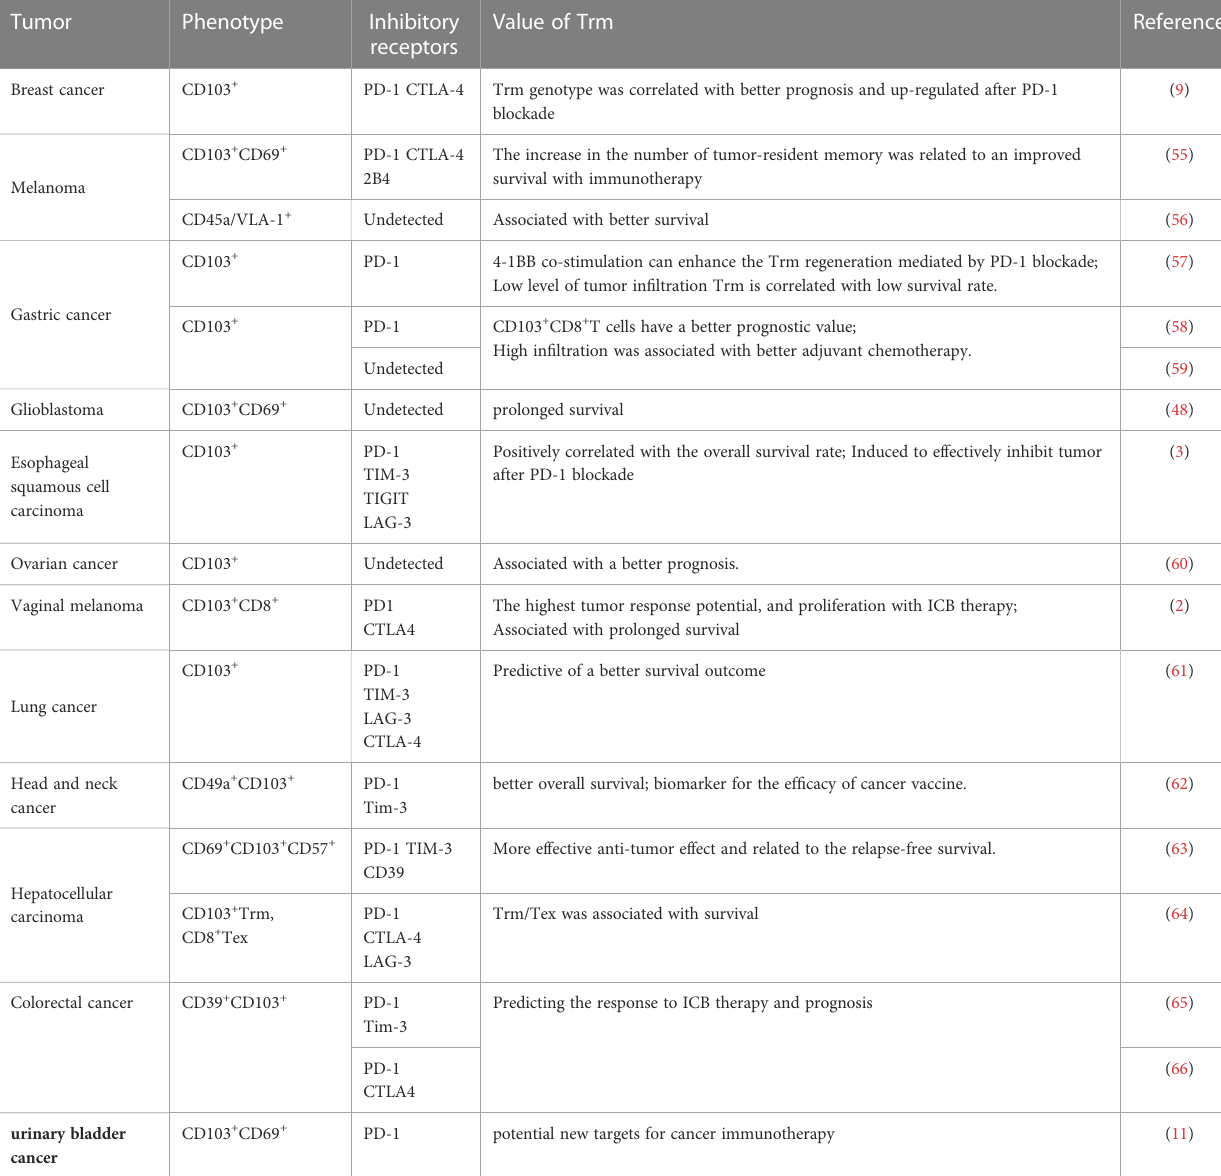
TABLE 1 Overview of Trm phenotypes and functions in various tumors.